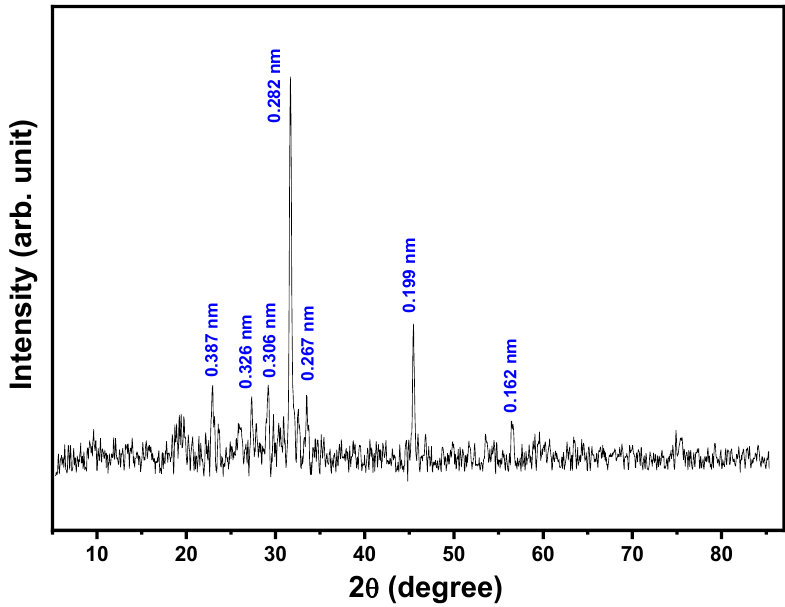
Figure 5. X-ray diffraction pattern of EPSR4.